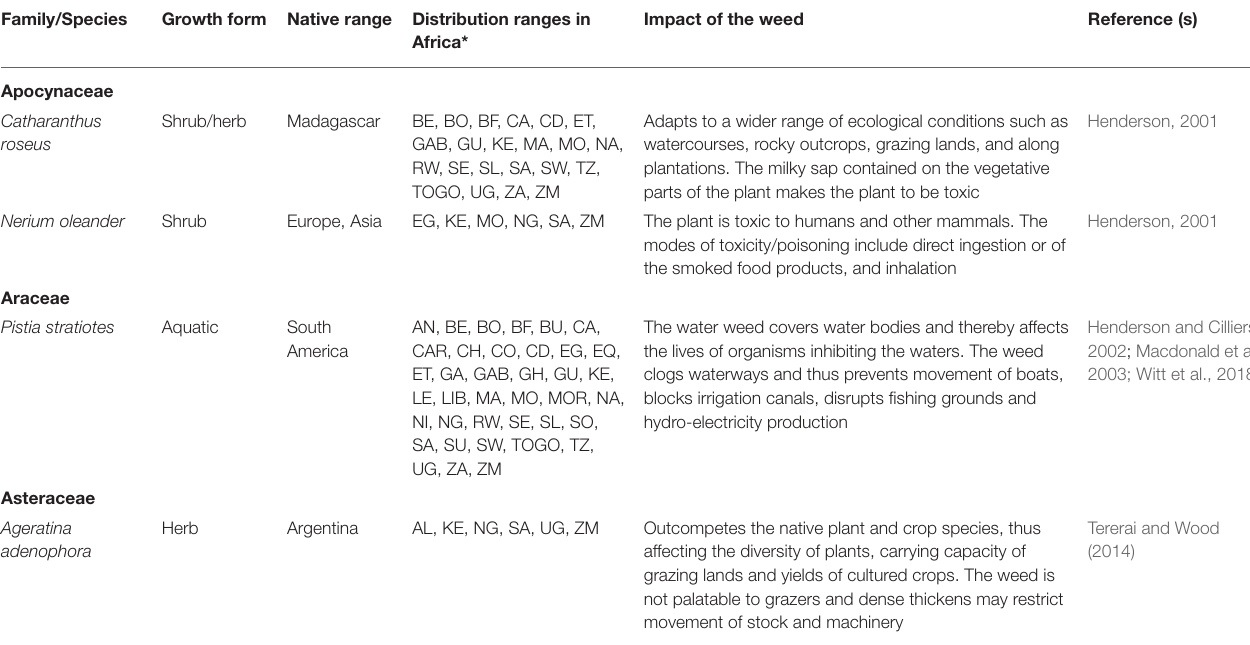
TABLE 1A | Published reports on the impact of some invasive alien plants in sub-Saharan